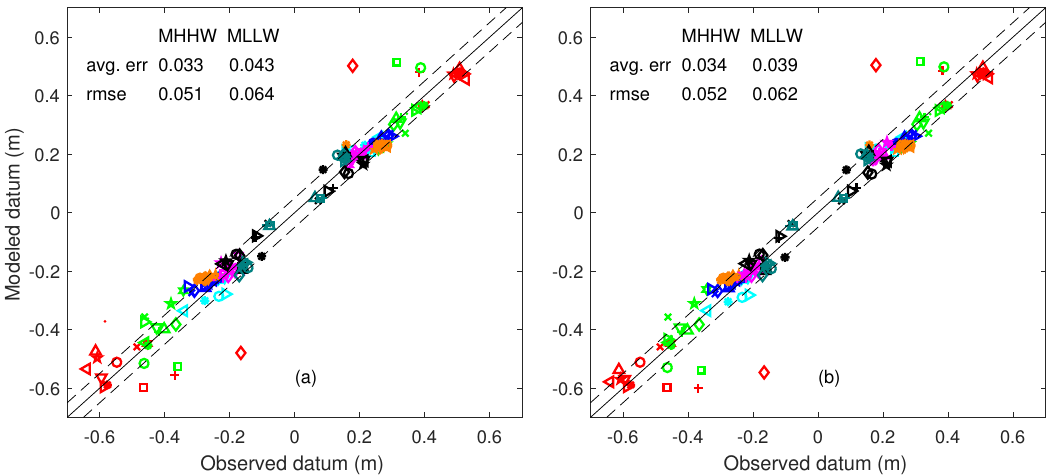
Figure 13. Sensitivity of modeled datum to water depth for stations outside VDatum region. ( a ) Two types of large model error at early stage of testing. ( b ) Increasing minimum water depth resolved the underestimate at MLLW. See Figure 6c for the final results. The dashed lines indicate the 5-cm error